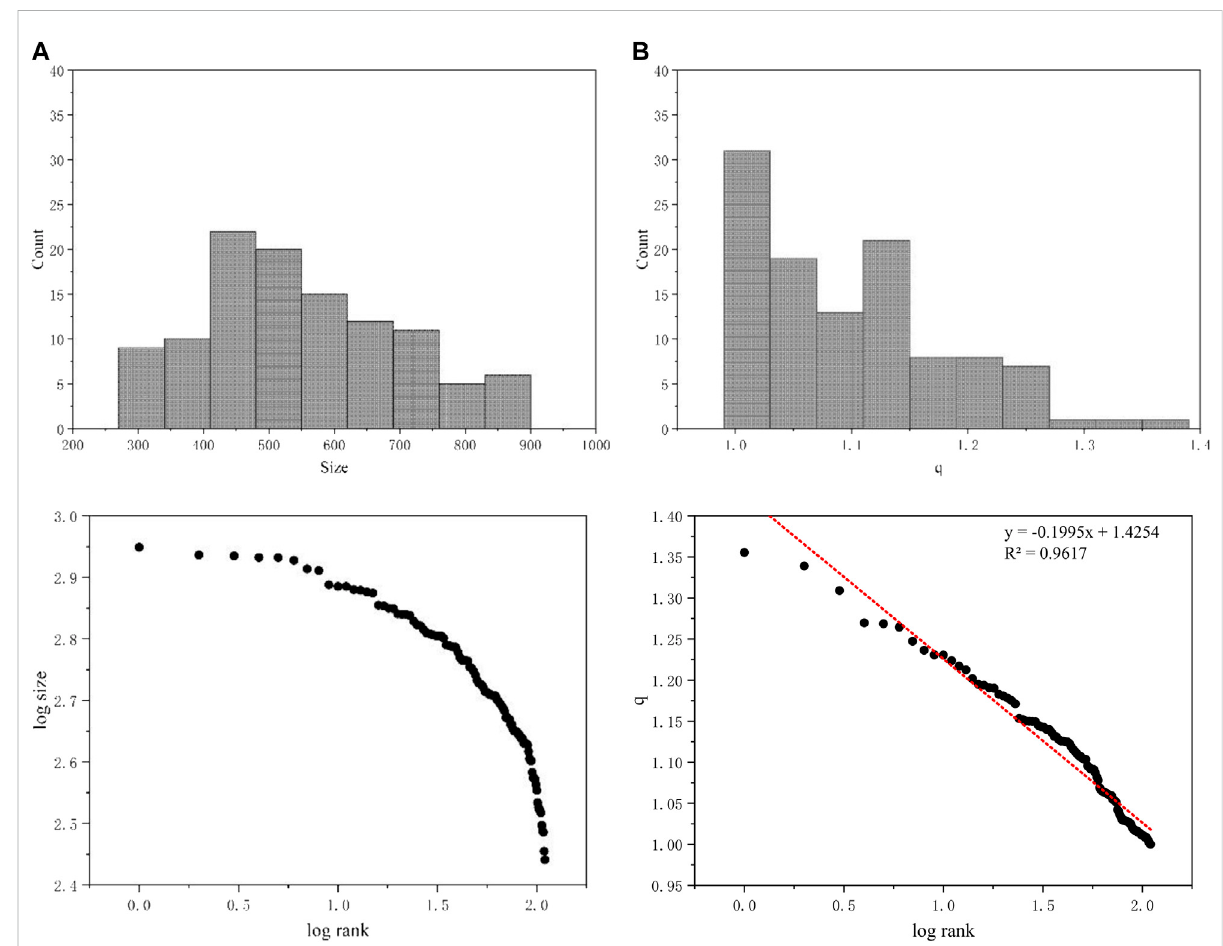
FIGURE 6 Density and rank-scale plot of the size (ground fl oor area) (A) and q value (B) of 110 courtyard houses in Haimen and